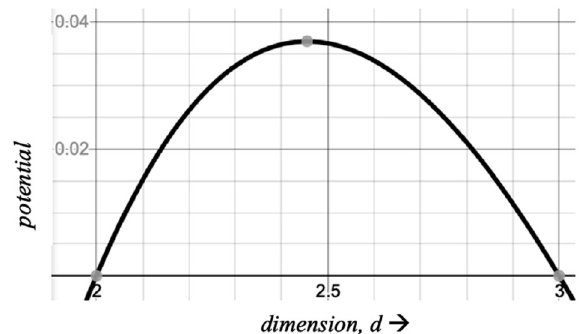
Figure 2. Potential p 3, A ( d ) with peak at